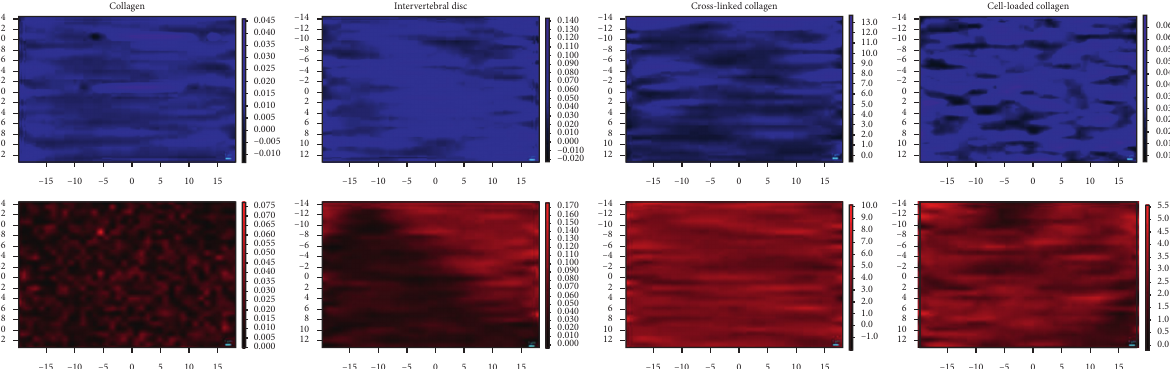
Collagen Intervertebral disc Cross-linked collagen Cell-loaded collagen